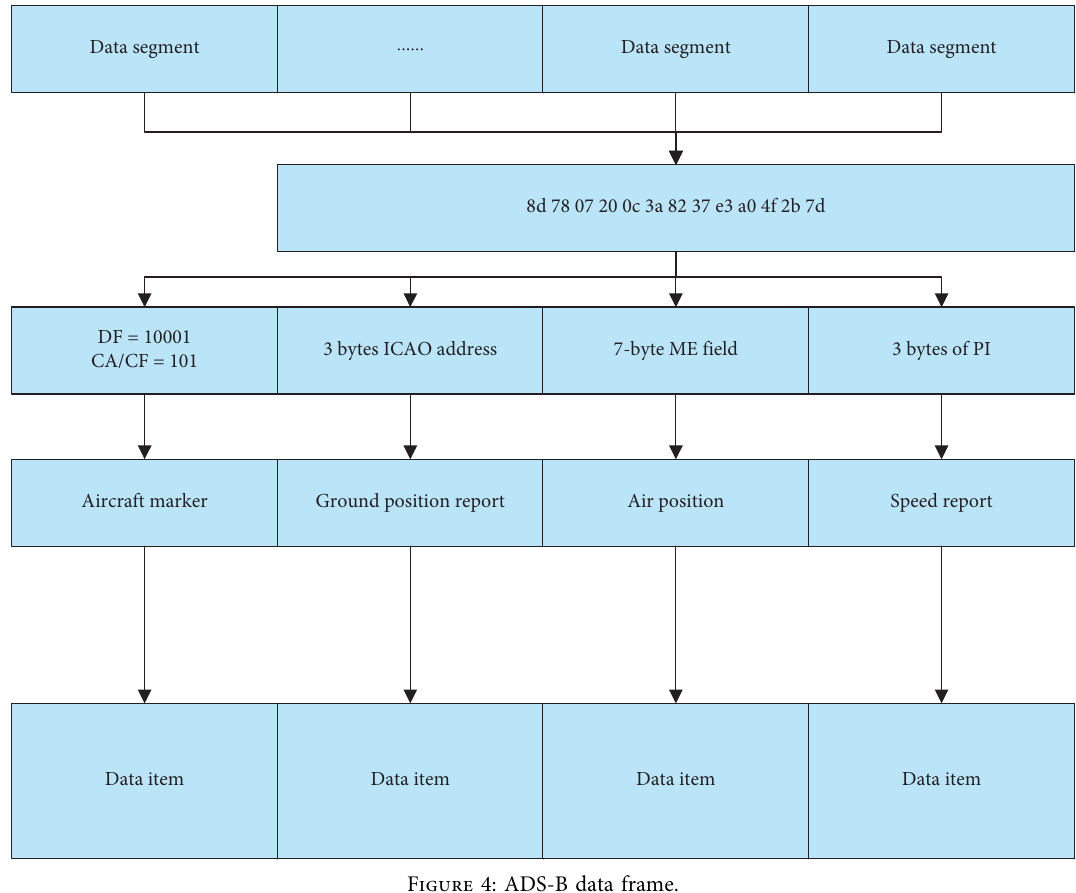
Figure 4: ADS-B data frame.